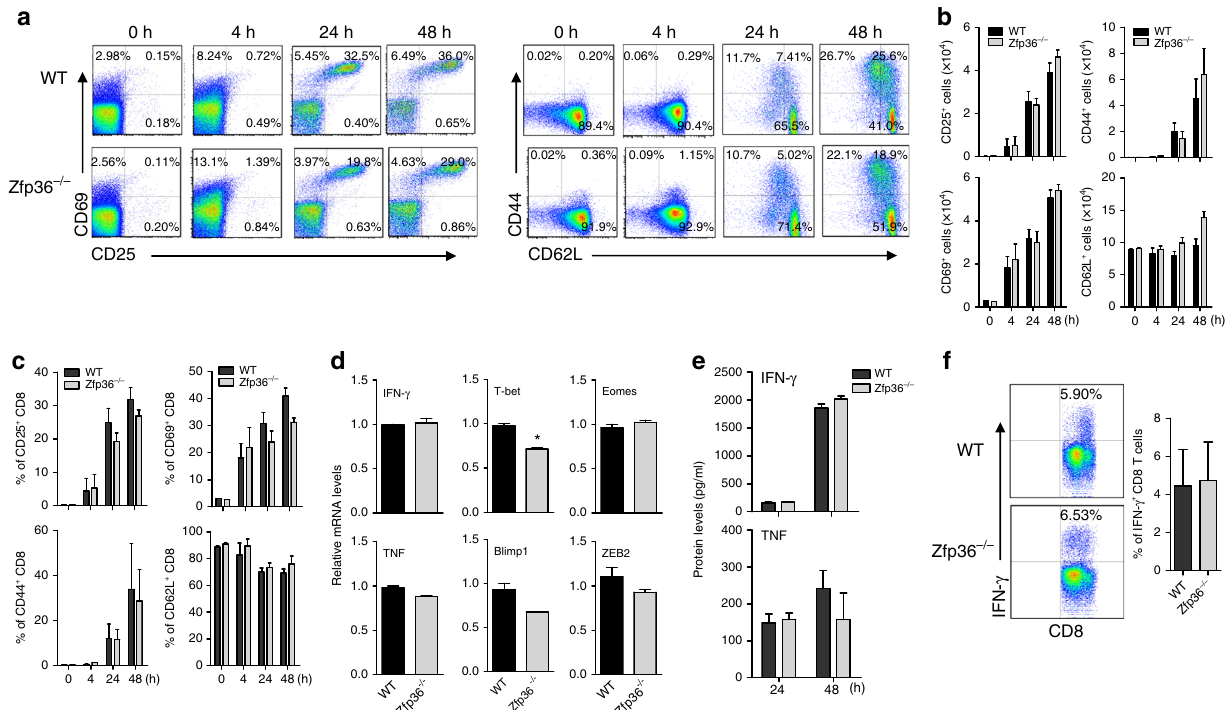
Fig. 2 Zfp36 − / − CD8 + T-cells have no intrinsic defect in IFN- γ production. a Naive CD8 T-cells from WT and Zfp36 − / − mice were stimulated by plate-coated α -CD3/CD28 Abs (1 μ g/ml). CD69, CD25, CD44 and CD62L surface expression were detected by FACS at different time points as indicated. b , c Quantitative data represent means ± s.d. of numbers b and percentages c of CD69 + , CD25 + , CD44 + and CD62L + CD8 T-cells as in a from three independent experiments. d Puri fi ed naive CD8 T-cells from WT and Zfp36 − / − mice were stimulated by plate-coated α -CD3/CD28 Abs (1 μ g/ml) for 72